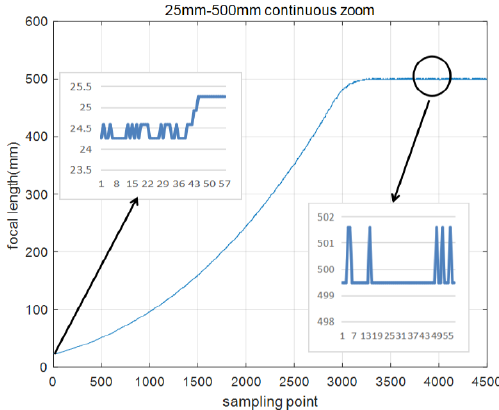
Figure 14. Zoom process from 25 mm to 500 mm.